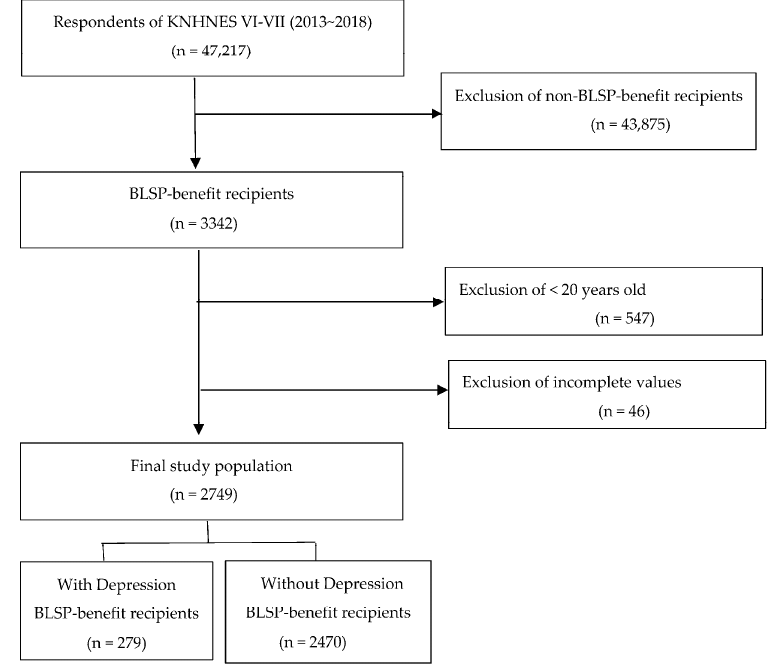
Figure 1. Flow chart of subjects .